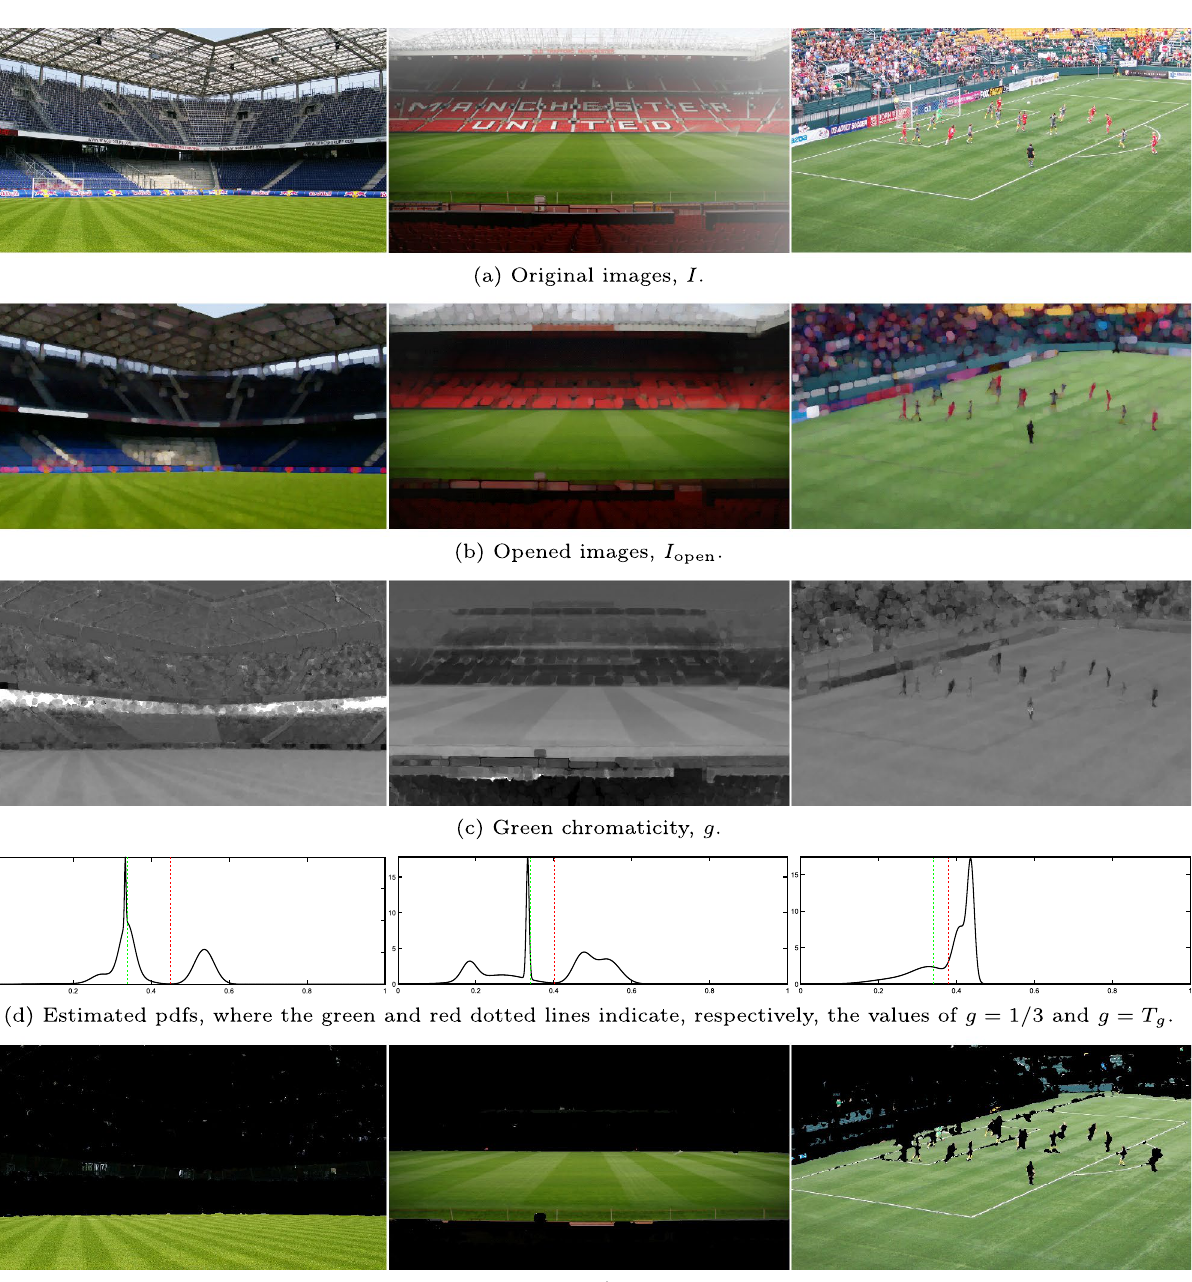
Figure 3. Results obtained on three images after applying the pre-processing and the analysis at the pixel level. Original images from 46,47 , and 48